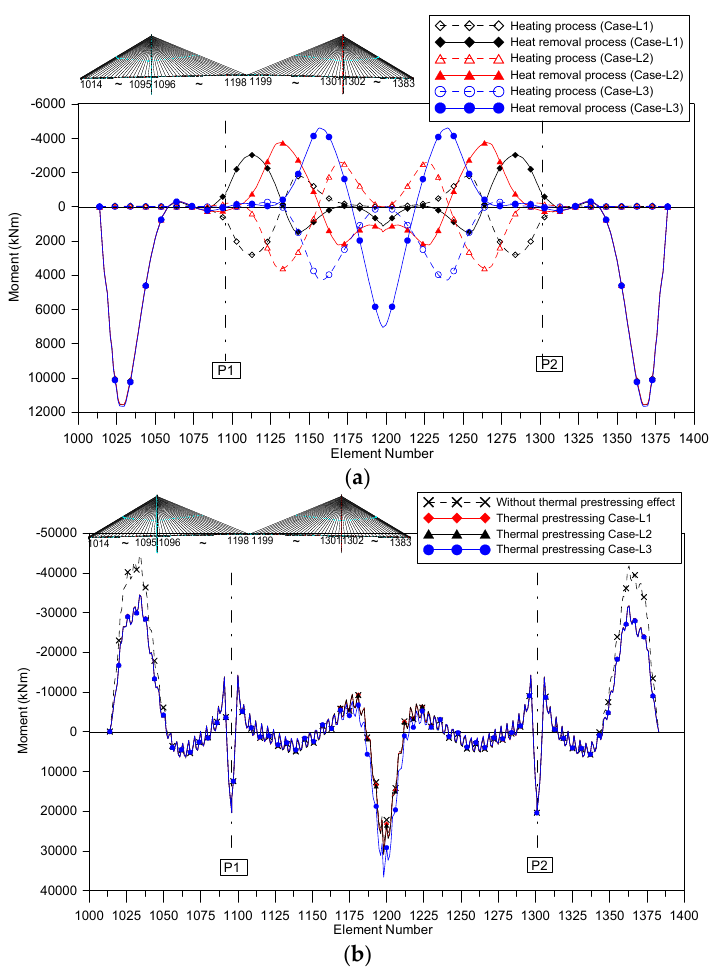
Figure 7. Girder moments according to the heating region. ( a ) Girder moments generated by heating and heat removal processes; ( b ) Girder moments after completed construction.